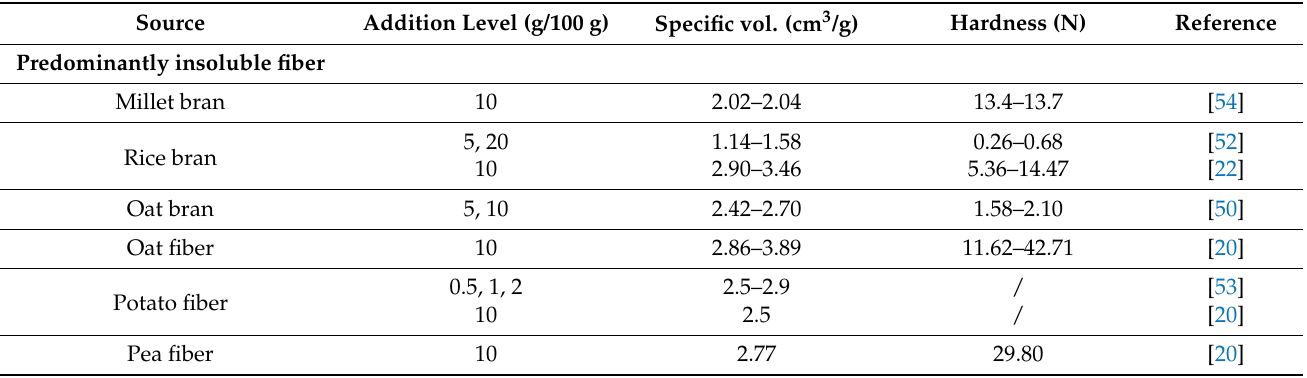
Table 2. Specific volume and hardness values reported for gluten-free breads with predominantly insoluble and soluble dietary